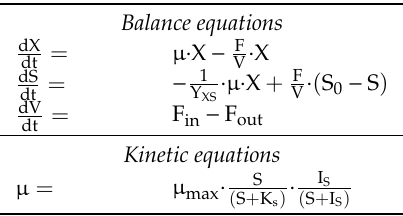
Table A7. Model equations for NMPC: Model B + .